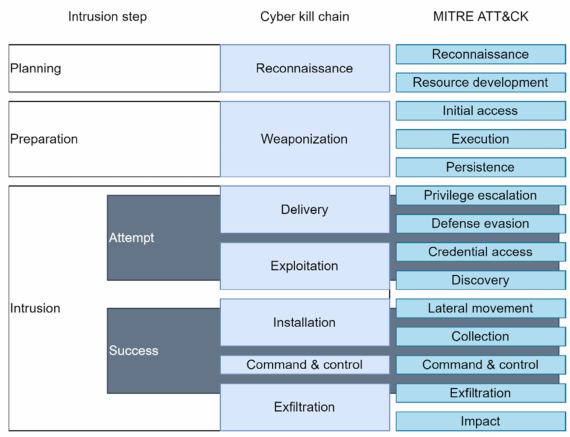
Figure 1. CKC vs. MITRE